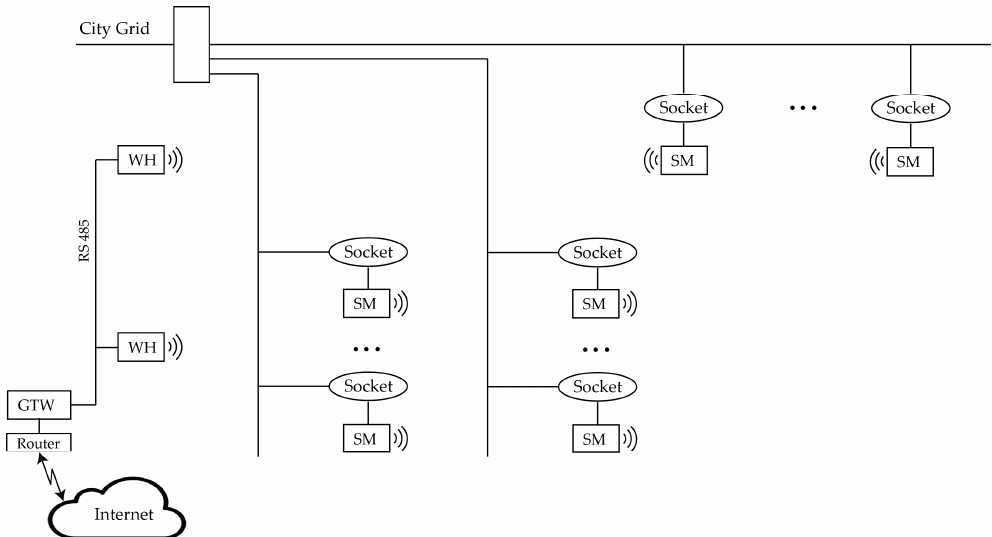
Figure 7. Wireless-sensor network for monitoring residential loads (SM—smart meter, WH— wireless hub, GTW—gateway).